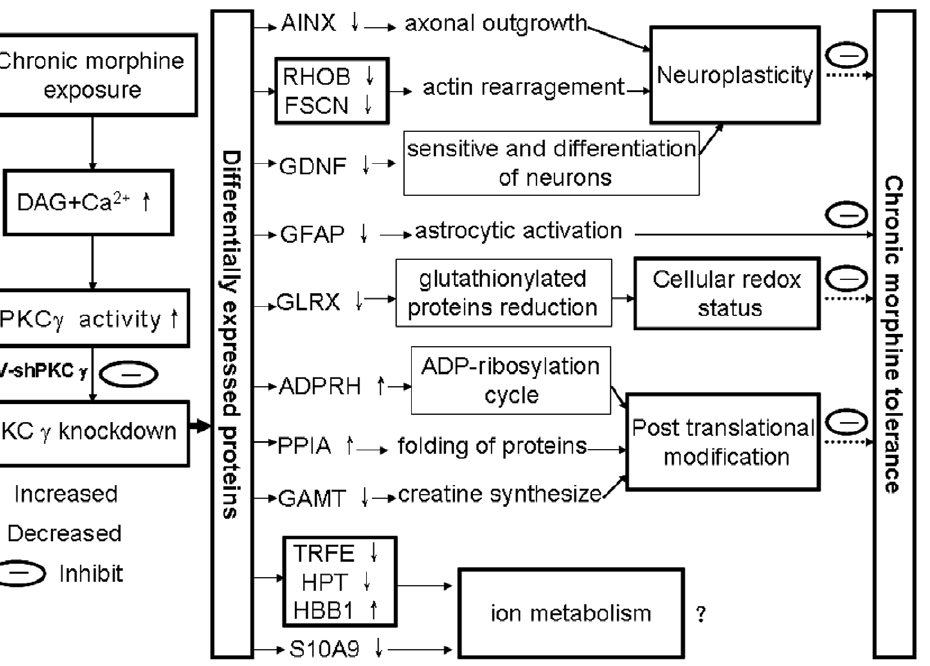
Figure 6. Experimental data-based diagram that rationalizes each DEP in the biological system that PKCa˜ down-regulation inhibits morphine tolerance. AINX, alpha-internexin; RHOB, Rho-related GTP-binding protein RhoB; FSCN, fascin; GDNF, glial cell line-derived neurotrophic factor; GFAP, glial fibrillary acidic protein; GLRX, glutaredoxin; ADPRH, Protein ADP-ribosylarginine hydrolase; PPIA, peptidyl-prolyl cis-trans isomerase A; GAMT, guanidinoacetate N-methyltransferase; TRFE, serotransferrin; HPT, haptoglobin; HBB1, hemoglobin subunit beta-1; S10A9, protein